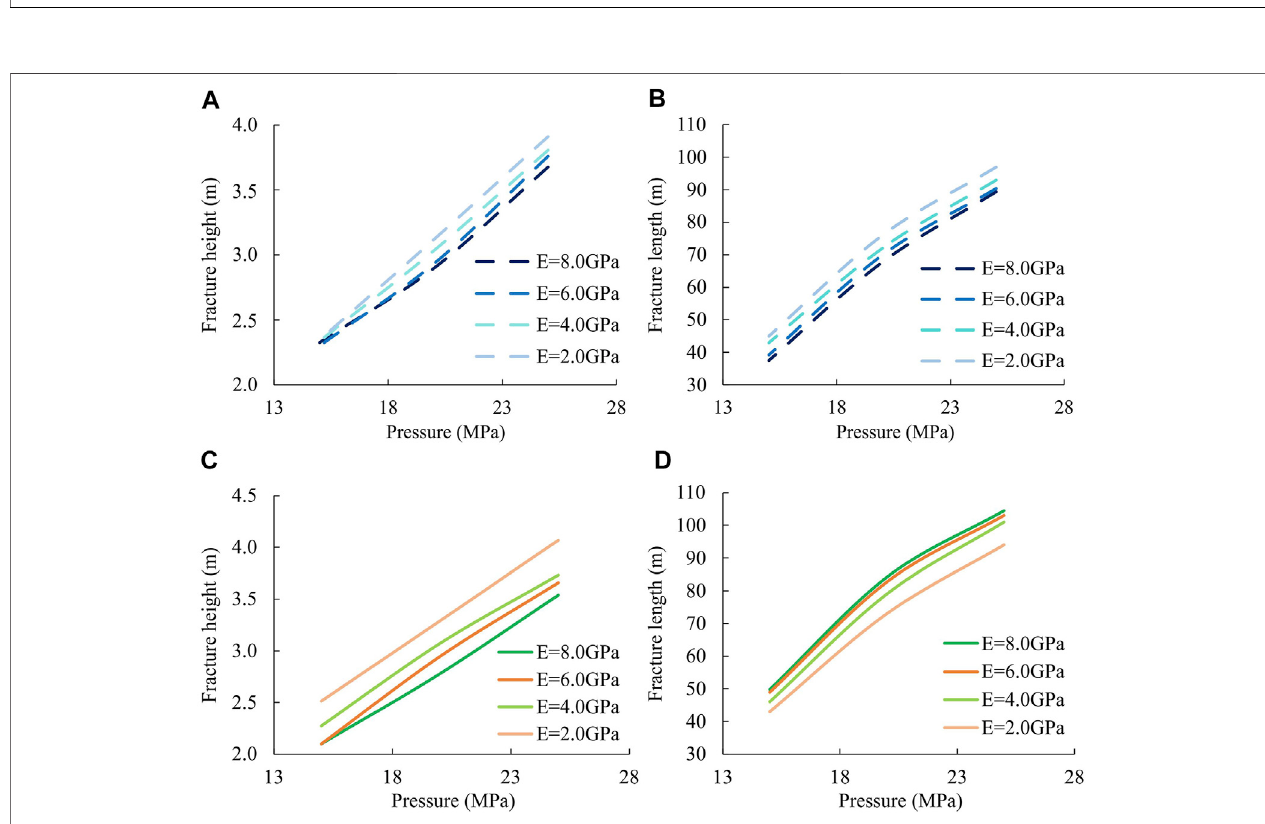
FIGURE8| FractureparametersunderdifferentYoung ’ smodulusoftheNo.13coalseam. (A) ThefractureheightoftheNo.9coalseam. (B) Thefracturelengthof the No. 9 coal seam. (C) The fracture height of the No. 13 coal seam. (D) The fracture length of the No. 13 coal seam.